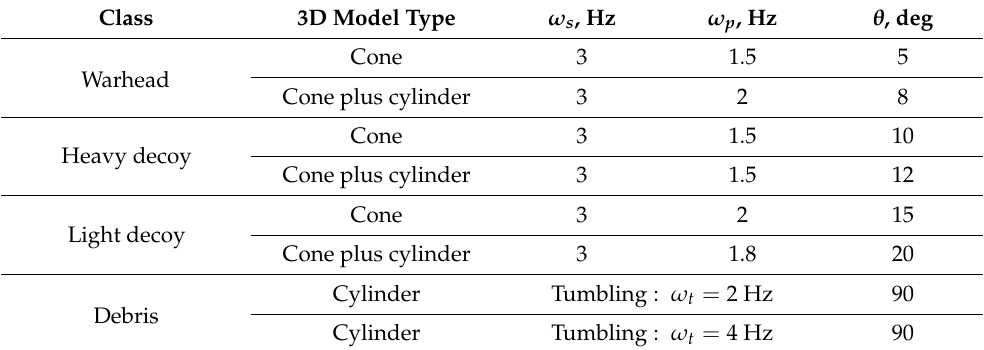
Table 2. Target micro-motion